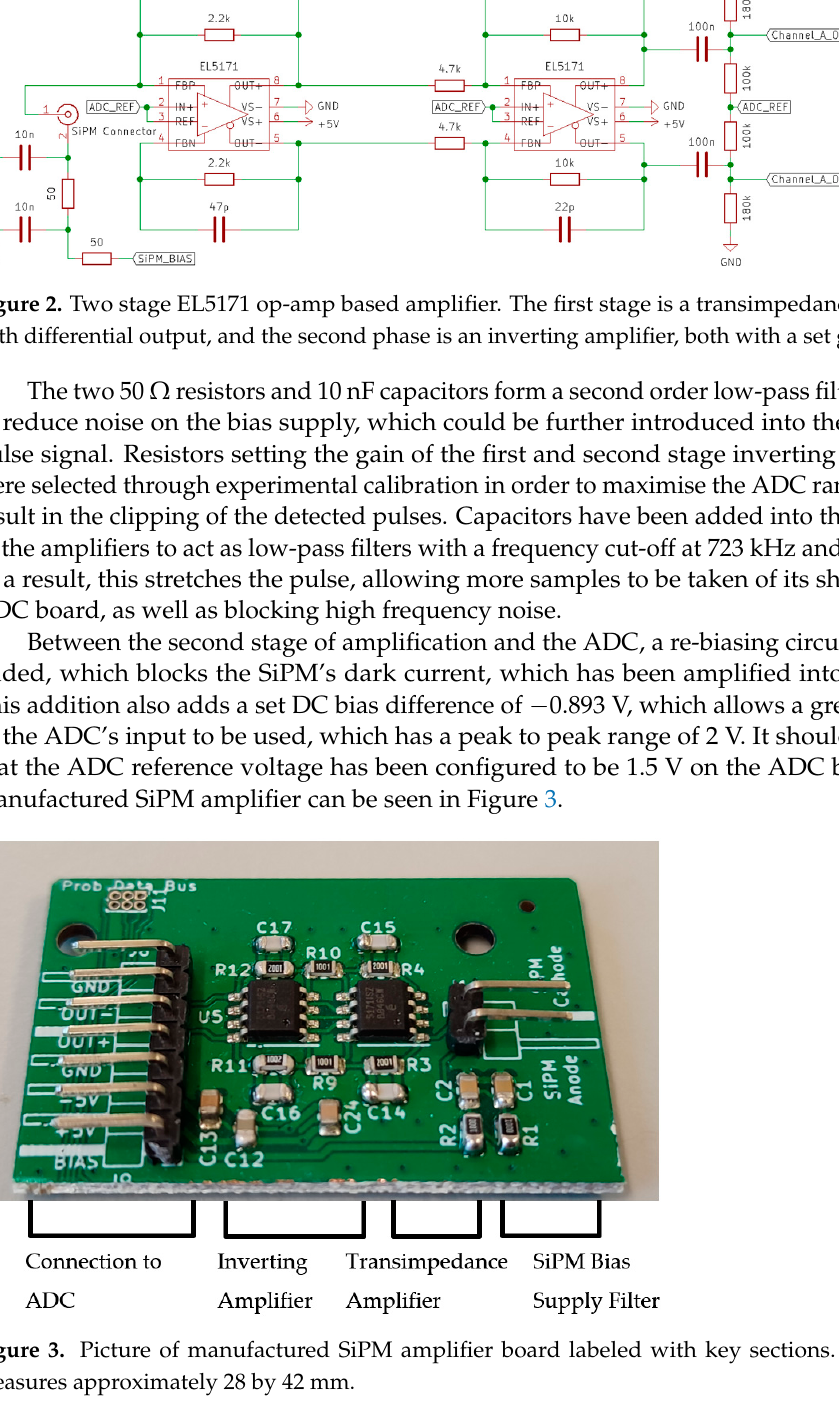
Figure 1. Block diagram of the whole backend system including the digital processing and database access method.